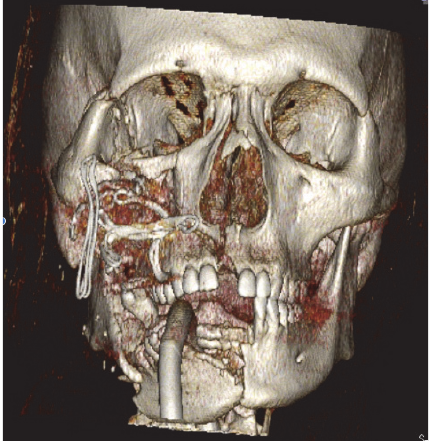
Figure 1: Three-dimensional reconstruction of the skull underlines the multiple facial fractures.